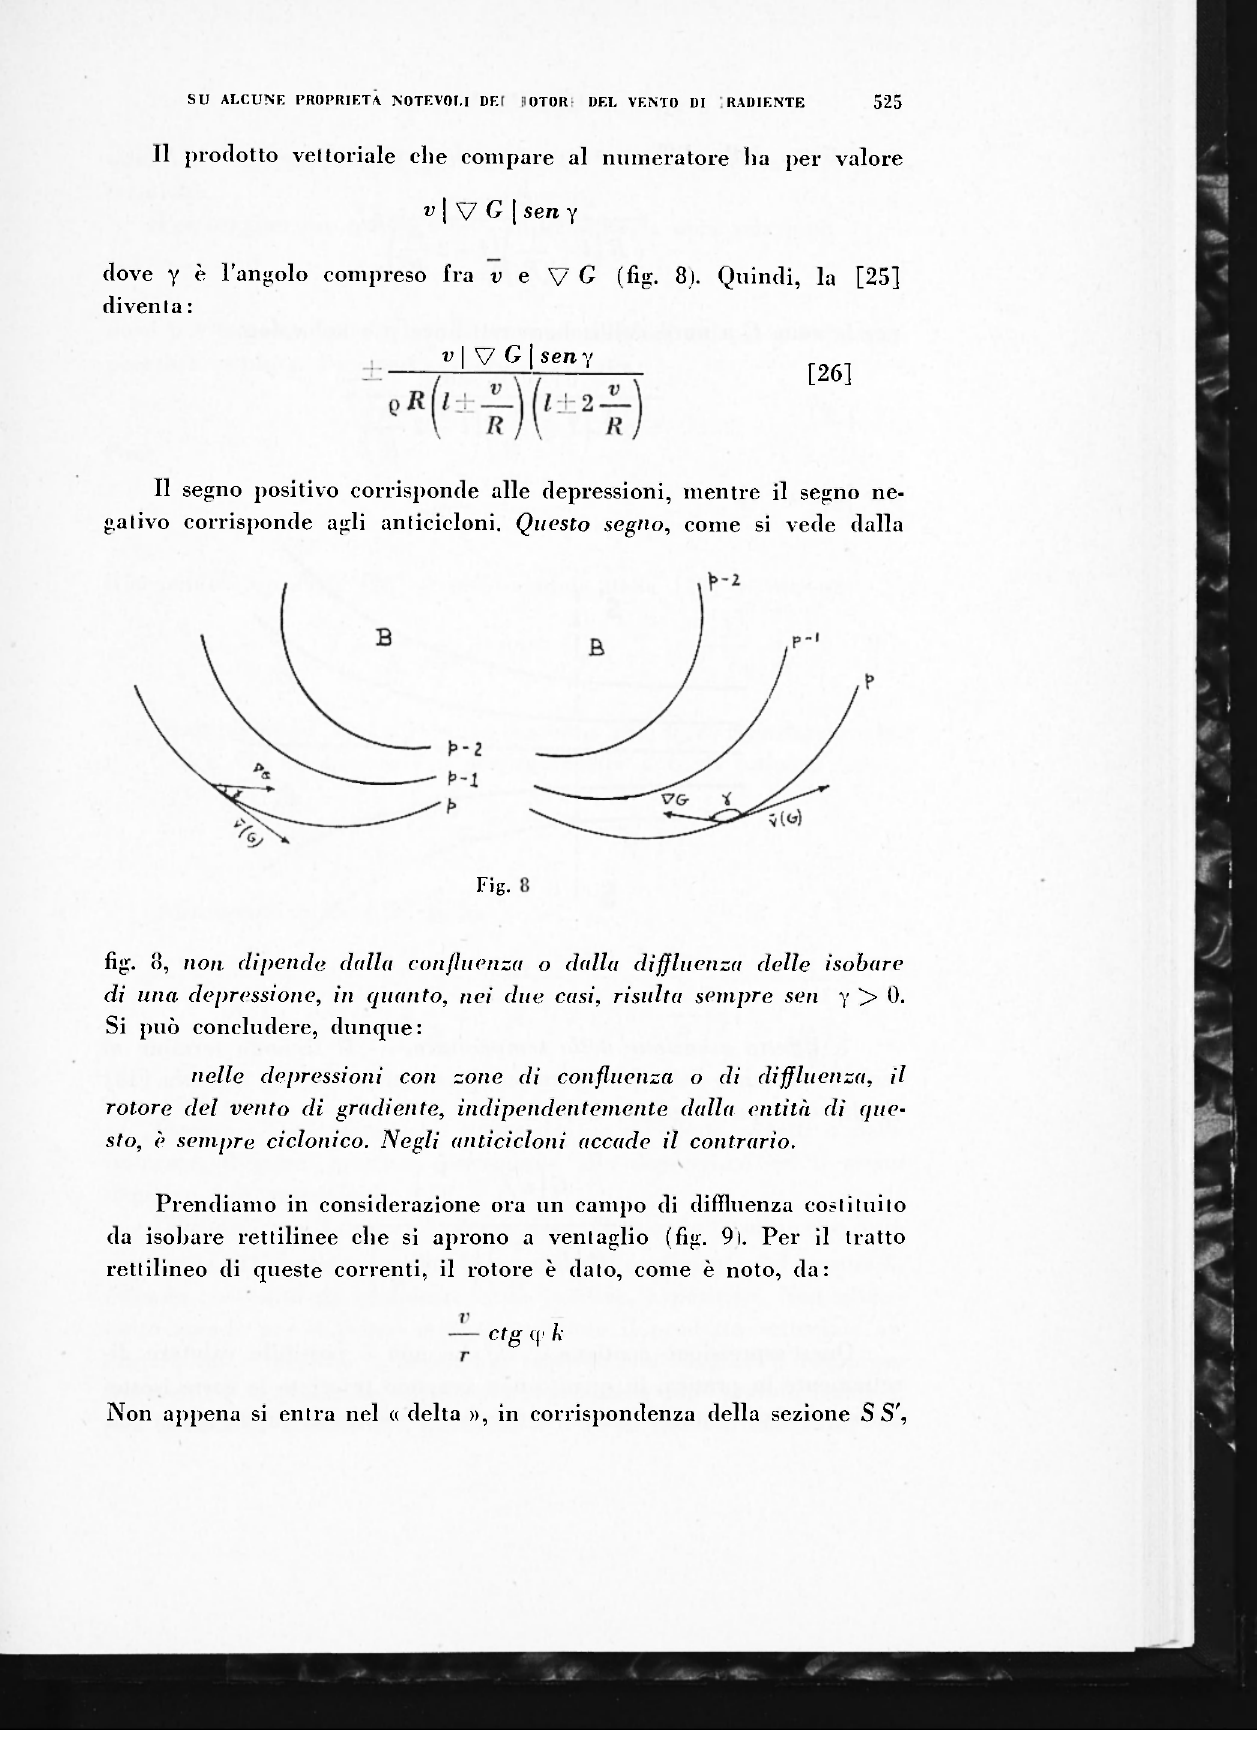
fig. 8, non di pende dalla confluenza o dalla diffluenza delle isobare di una depressione, in quanto, nei due casi, risulta sempre sen y >